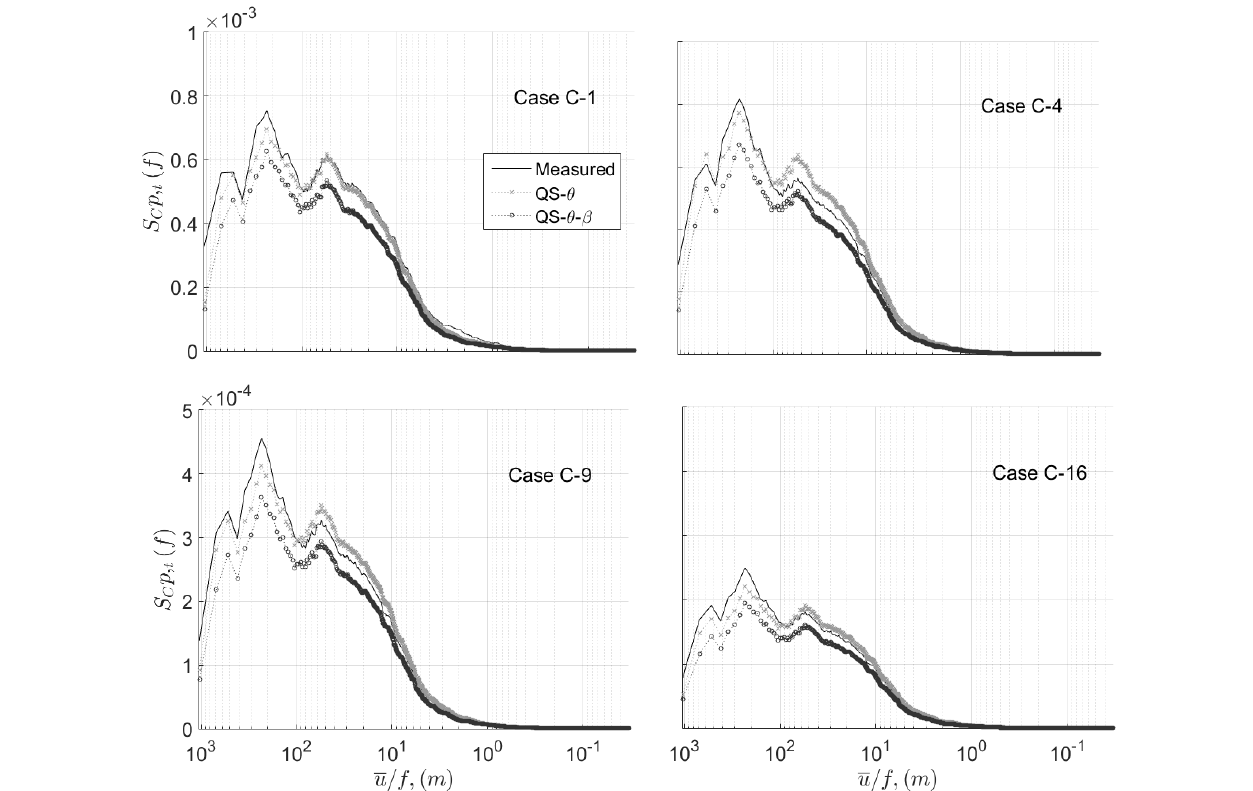
FIGURE 7 | Spectra of measured and quasi-steady predicted C p,t for cases C-1, C-4, C-9, and C-16, mean wind azimuth (cid:22) θ (cid:22) θ (cid:22) θ =